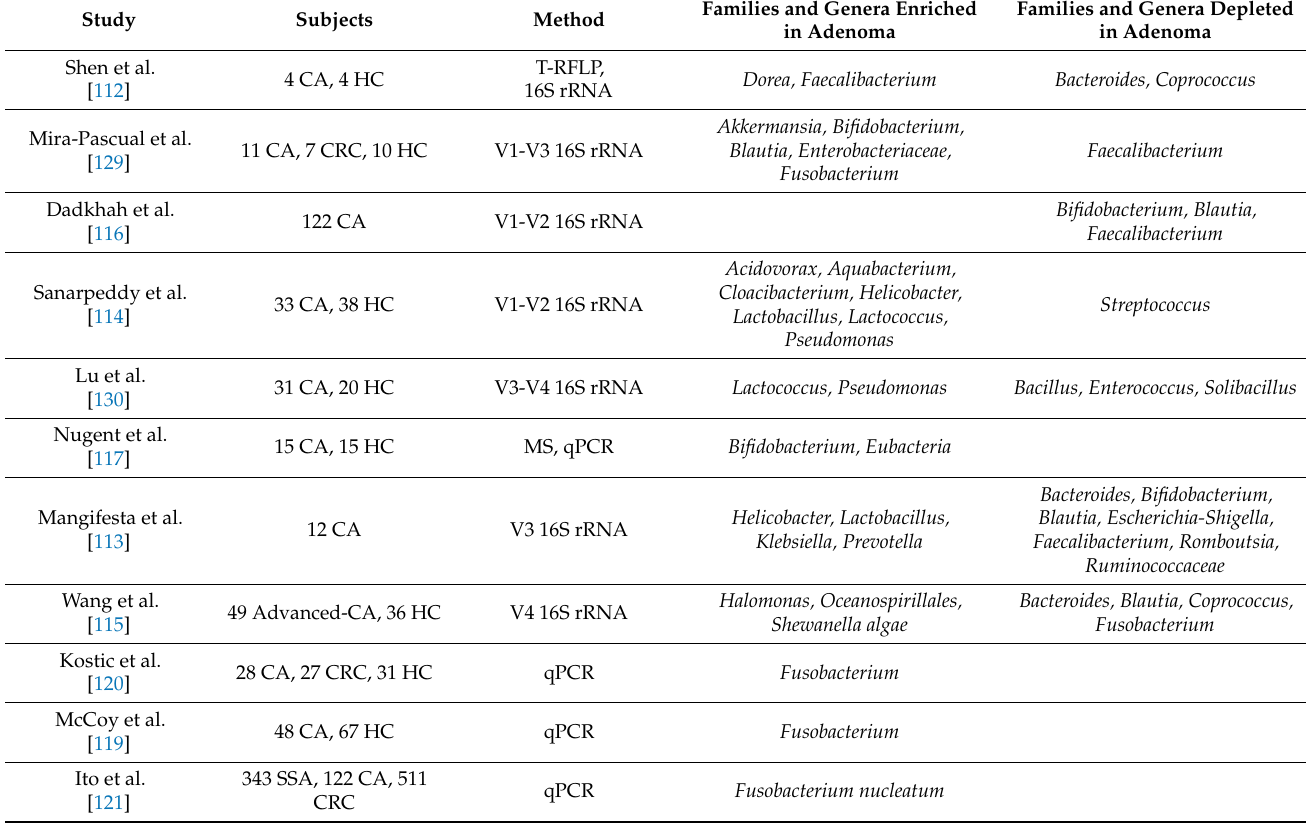
Table 2. Studies examining microbiomes from human gut mucosal